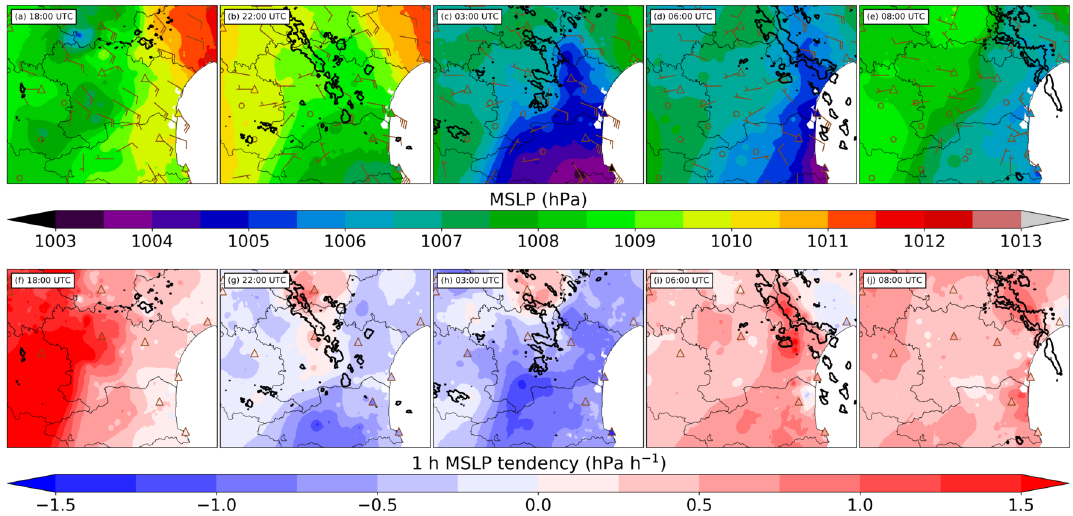
Figure 14. SPWS analyses of (a–e) MSLP and (f–j) 1h MSLP tendency at 18:00, 22:00UTC on 14 October and 03:00, 06:00, 08:00UTC on 15 October. Brown triangles show SWS MSLP observations, and brown barbs show SWS wind observations. Bold black contours indicate radar reflectivities above